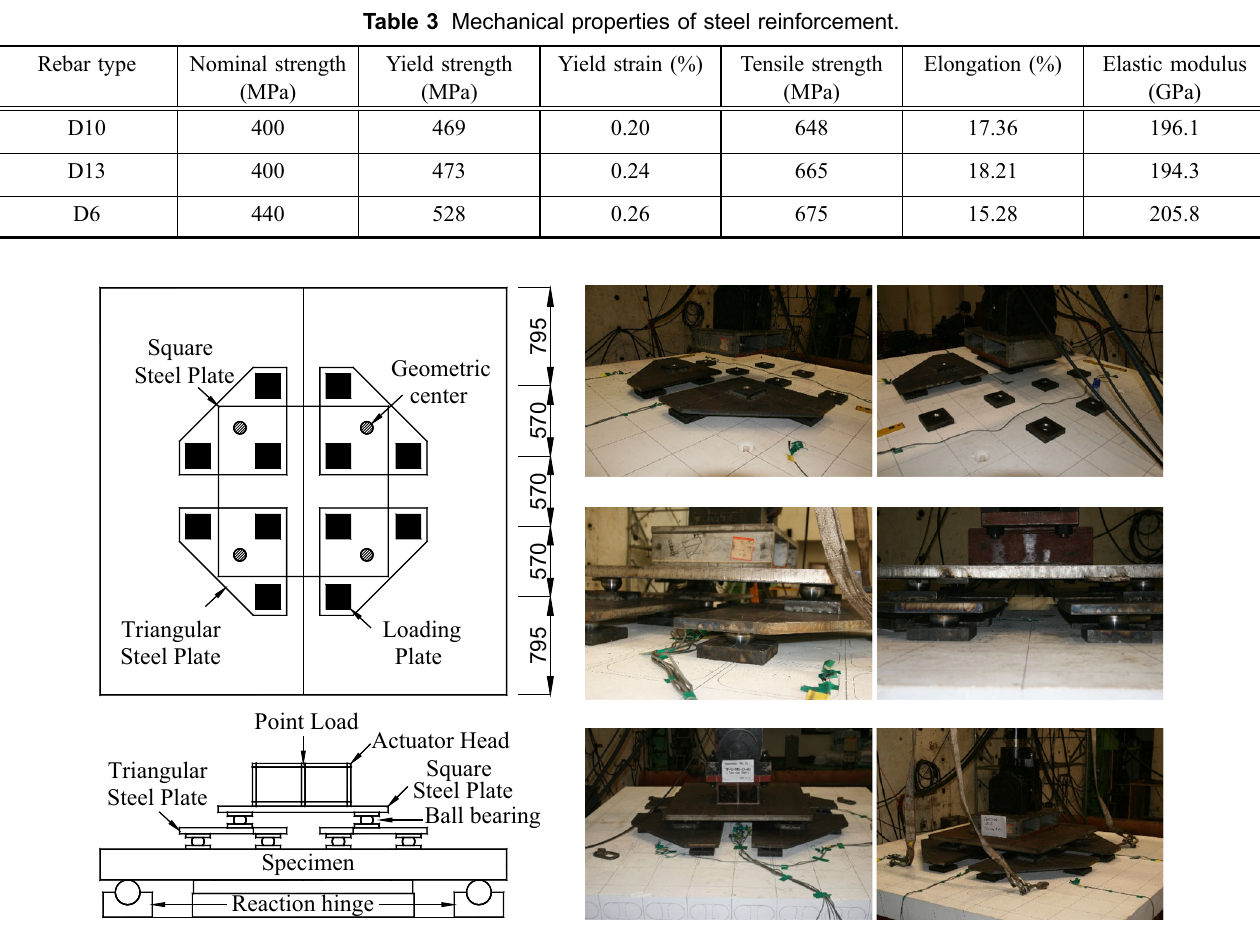
Fig. 4 Installation of 12-point loading system (unit: mm).